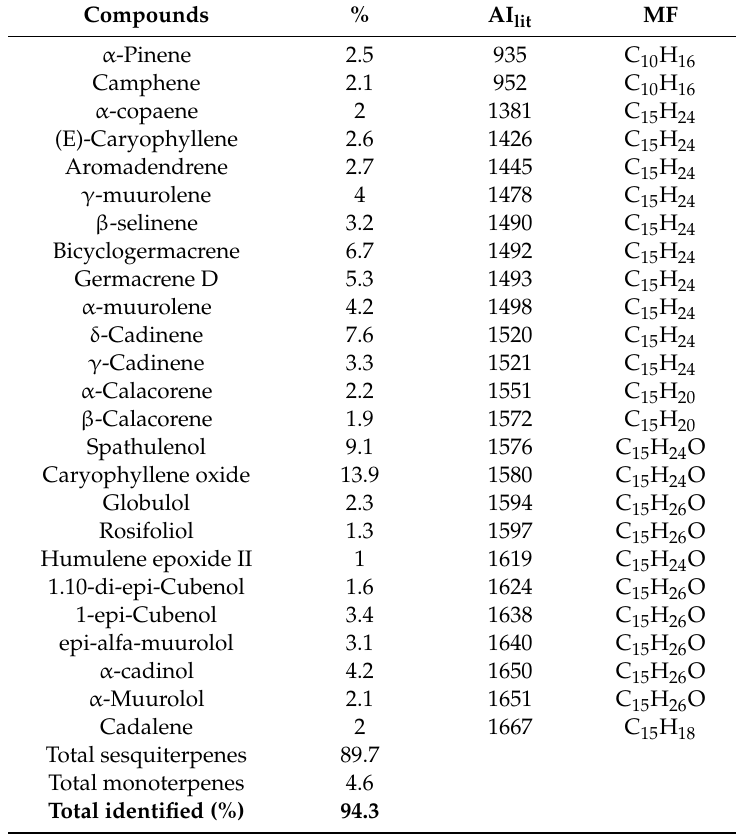
Table 1. Chemical composition of the essential oil of leaves from Piper caldense .